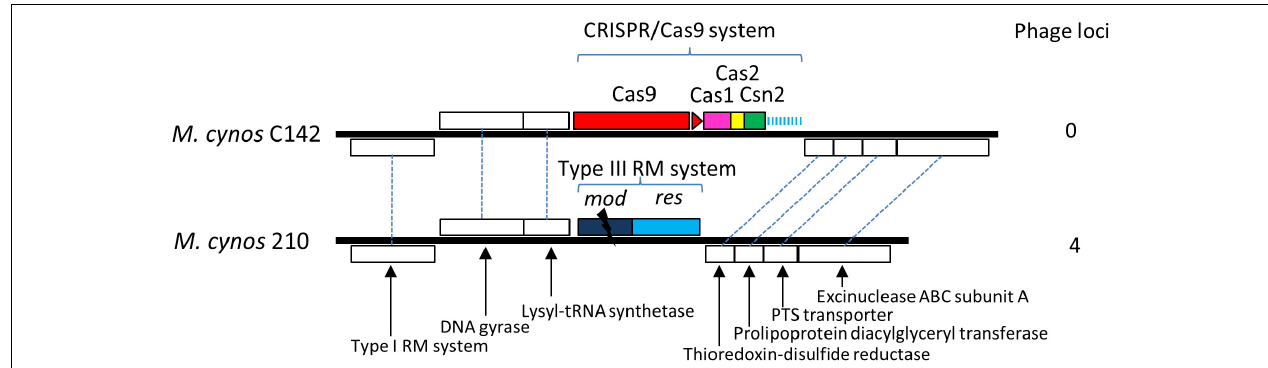
FIGURE 5 | Comparative genomics of CRISPR locus in two strains of M. cynos . Syntenic CDS shared by strains C142 (MCYN0853 – MCYN0843) and 210 (MCYNC210_0918 – MCYNC210_0909) are represented by white boxes connected by dashed lines. The CRISPR/Cas9 locus found in C142 is replaced by genes encoding a Type III restriction/modification system in strain 210. The disrupted mod gene of this system is indicated by a black flash. Number of genome regions encoding prophage parts are indicated.